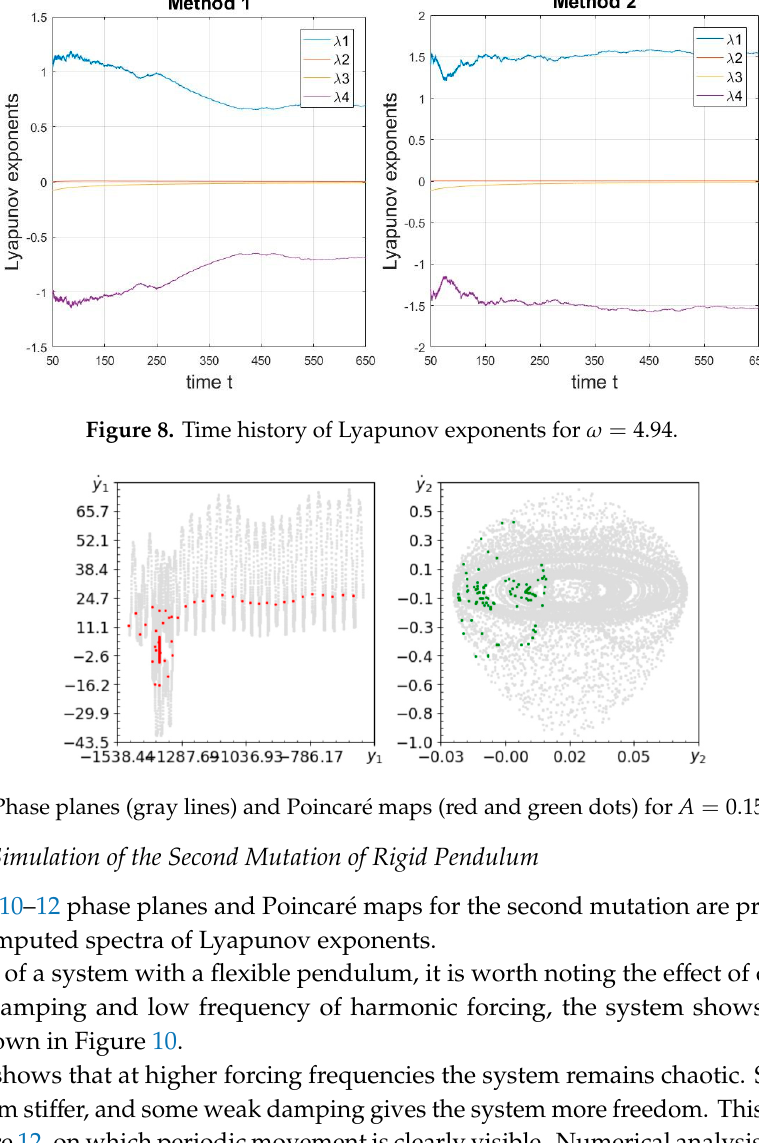
Figure 10. Phase planes (gray lines) and Poincaré maps (red, green and blue dots) for (cid:1829) = 0.05 , (cid:1863) = 40 and (cid:2033) = 2.84 .